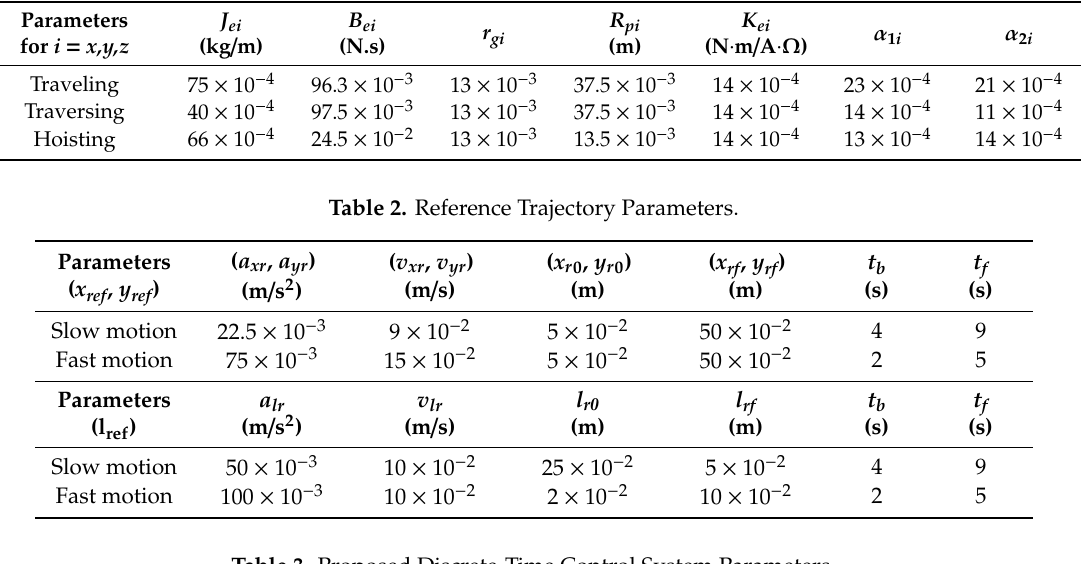
Table 3. Proposed Discrete-Time Control System